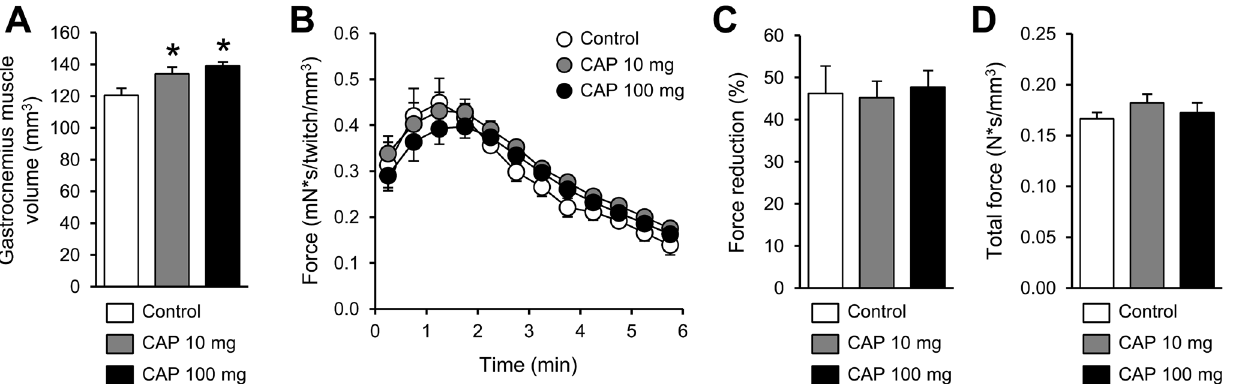
Fig 1. Muscle anatomy and mechanical performance in vivo. Gastrocnemius muscle volume (A) and force produced throughout the 6-min fatiguing electrostimulation protocol performed at the end of 2-week treatment with vehicle (control) or capsiate (CAP) at 10- or 100-mg/kg body weight (B). Extent of force reduction measured at the end of the protocol and expressed as percent of onset value (C). Total amount of force produced during the whole 6-min electrostimulation (D). Data are means ± SEM. * Significantly different (one-way ANOVA; P < 0.05) from control.